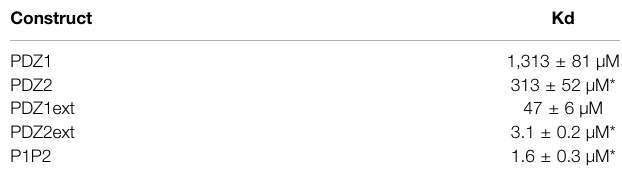
standard deviation of measured Kd values for at least ten signi fi cantly shifting